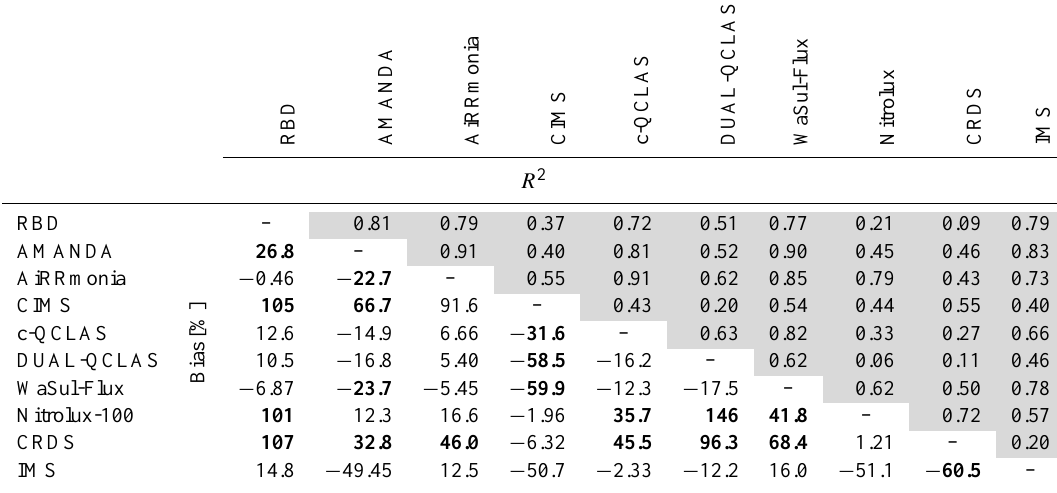
Table 7. Inter-comparison of correlation coefficients and biases between each instrument of data less than 10ppbv. Biases are given in the bottom half and correlation coefficients are indicated by the top (grey) of the matrix. Bold numbers indicate high biases ( >